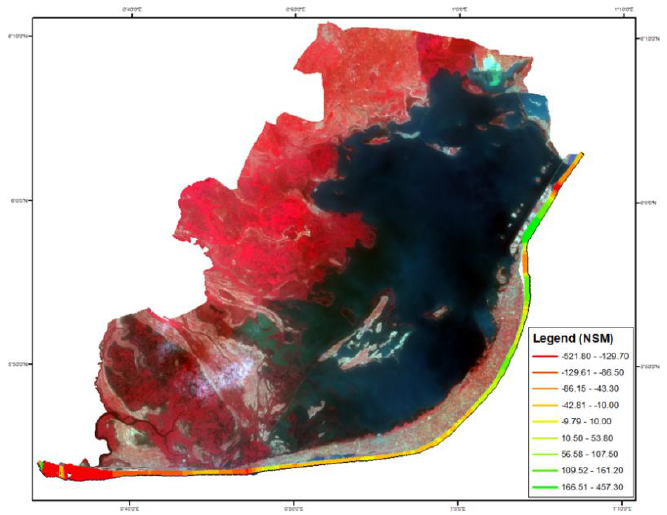
Figure 4. Rate of shoreline change from 2000-2021 (Negative values in red and yellow indicates erosion whereas the positive values in green colours indicate accretion).